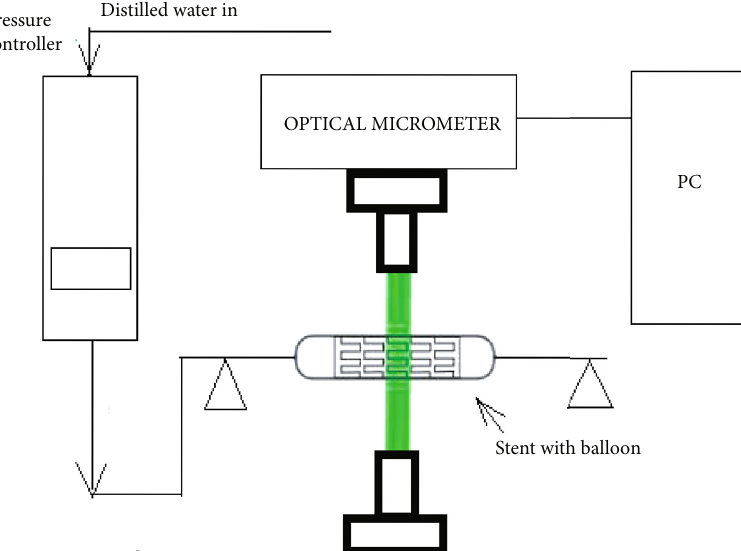
Figure 3: Schematic sketch of the experiment setup (courtesy: Sujesh et al. 2013).